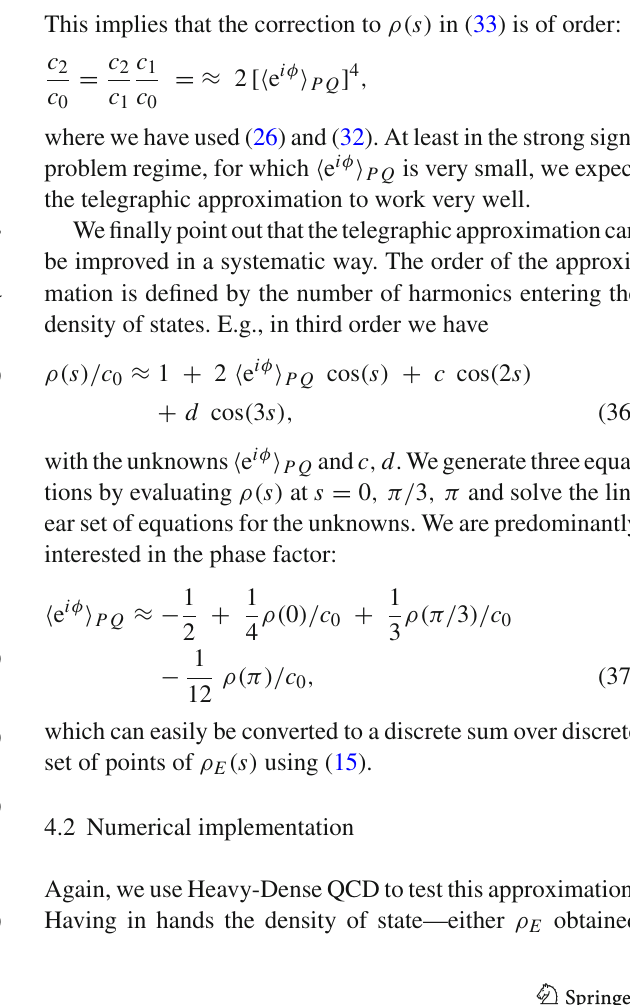
cedure. Our numerical findings are summarised in Fig.